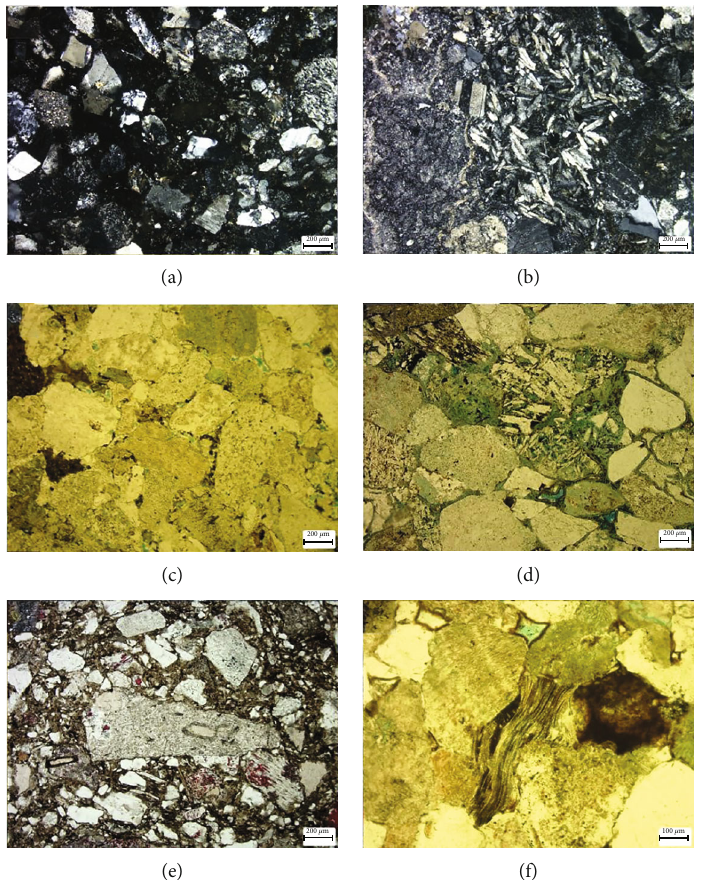
Figure 2: Petrological characteristics of tight clastic reservoirs. (a) Well Bei210, -4127.7m, feldspathic litharenites, cross-polarized light; (b) Well Bei210, -4129.65 m, litharenites, cross-polarized light; (c) Well Bei203, -3317.87m, litharenites, plane-polarized light; (d) Well Bei202, -3112.75m, litharenites, plane-polarized light; (e) Well Bei203, -3615.5, matrix support, plane-polarized light; (f) Well Bei201, -3398.01m, grain support, plane-polarized